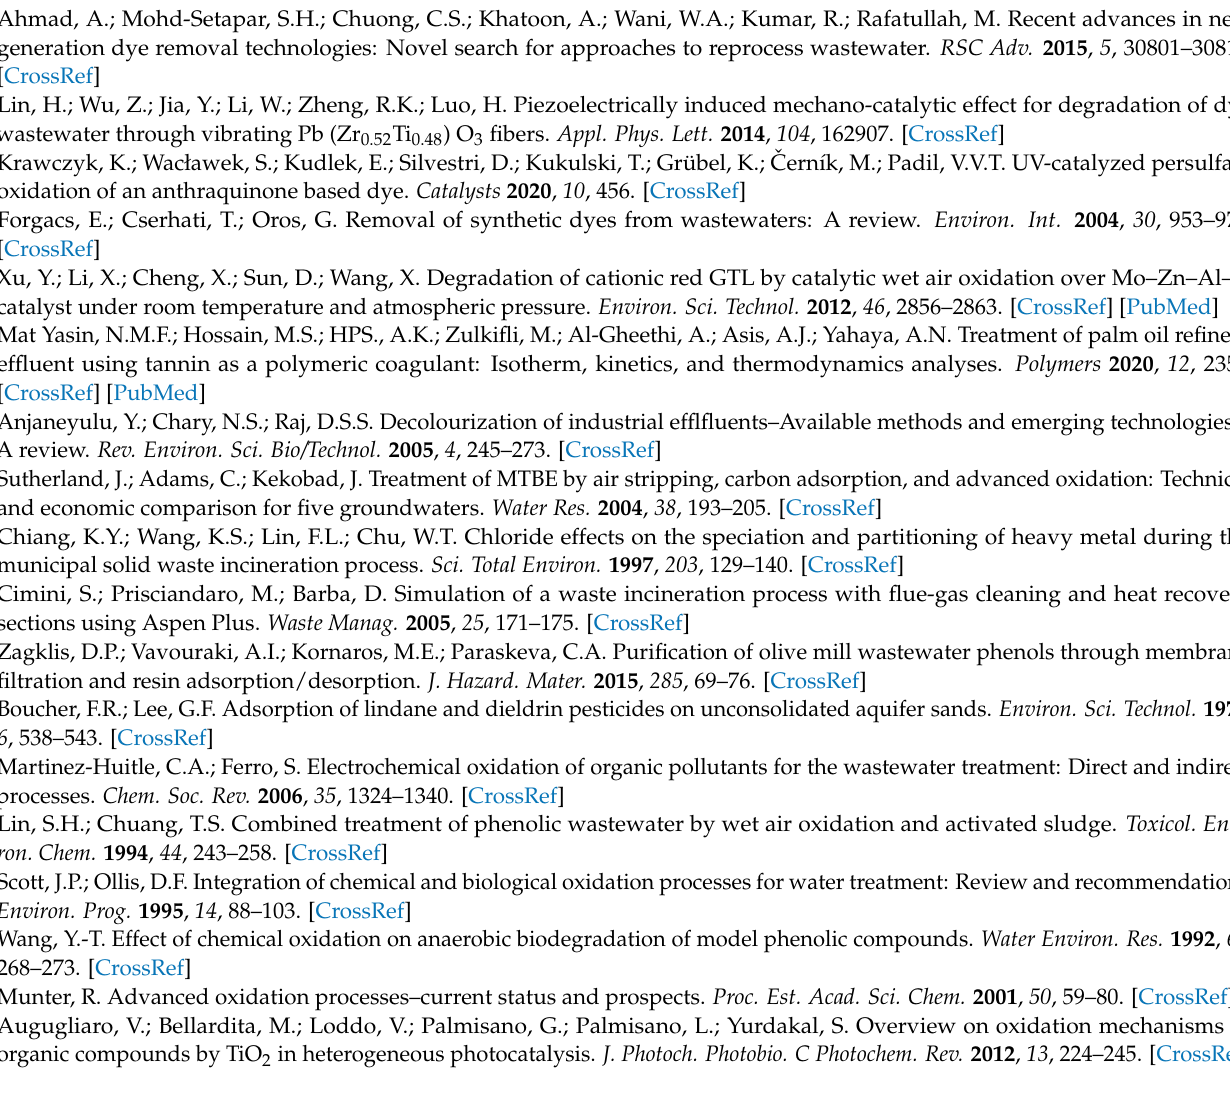
Figure S2. Pyrocatalytic UV absorption spectrum of RhB after